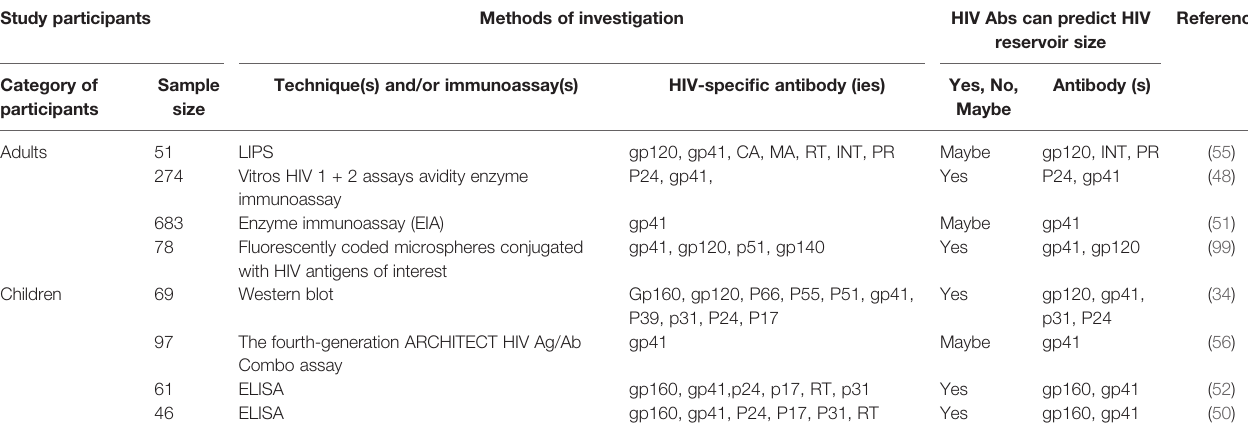
TABLE 1 | Summary of published articles (2016-2021) investigating HIV-1-speci fi c antibody capacity to estimate HIV-1 reservoir size. Study participants